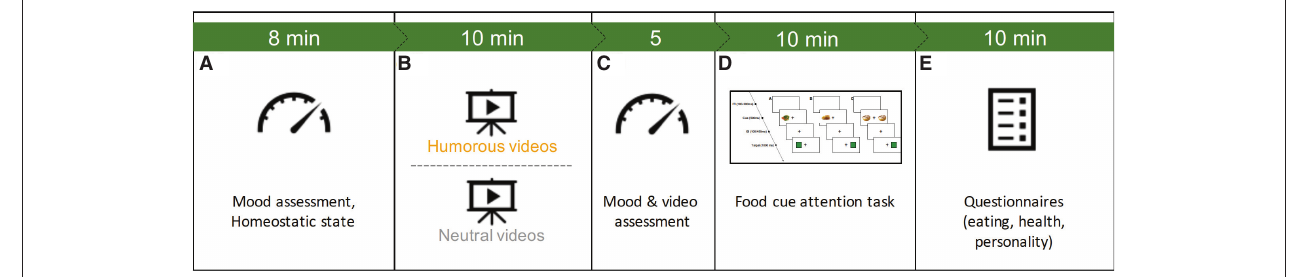
FIGURE 1 | Study procedure showing the five phases of the experiment: A, initial mood and homeostatic state assessment; B, mood induction via video clips; C, (re-)assessment of mood, self and videoclips, D, food cue attention task and E, self-assessments via questionnaires. The green bar denotes the approximated durations of the phases in minutes.